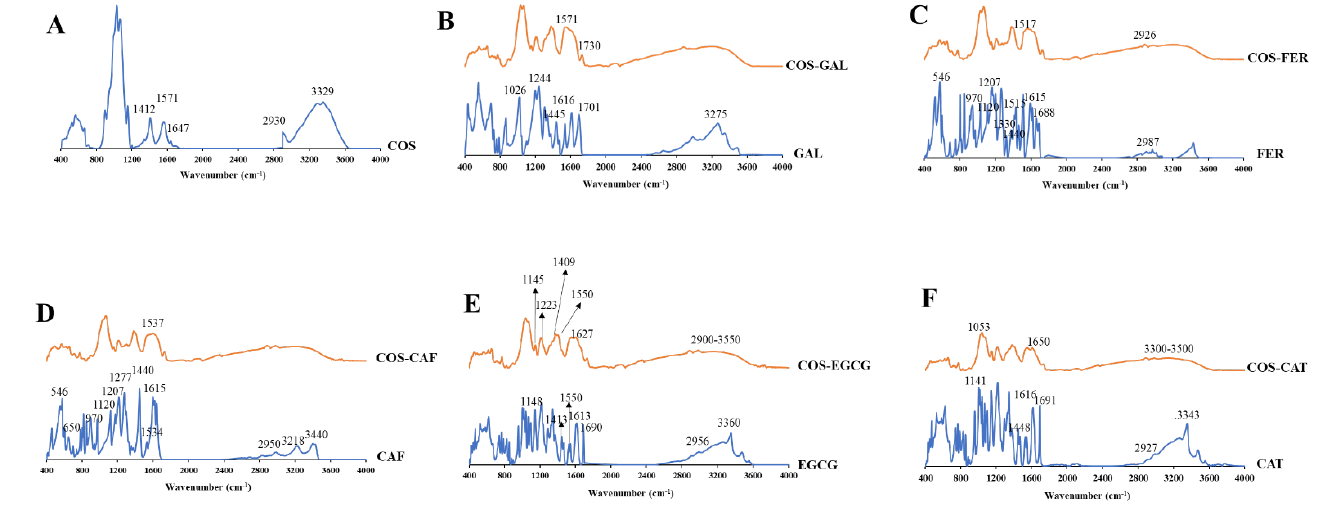
Figure 2. FTIR spectra of COS ( A ), GAL and COS-GAL ( B ), FER and COS-FER ( C ), CAF and COS- CAF ( D ), EGCG and COS-EGCG ( E ), and CAT and COS-CAT ( F ) : COS, chitooligosaccharide; GAL, gallic acid; FER, ferulic acid; CAF, caffeic acid; EGCG, epigallocatechin gallate; CAT, catechin. GAL exhibited -OH stretching and hydrogen bonding between 3500 to 3200 cm −1 [28].